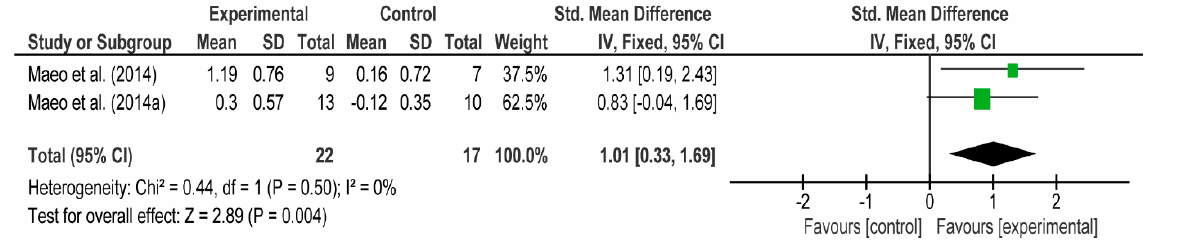
MT. References for the studies in the table with the same publication year are Maeo et al. (2014) [83],